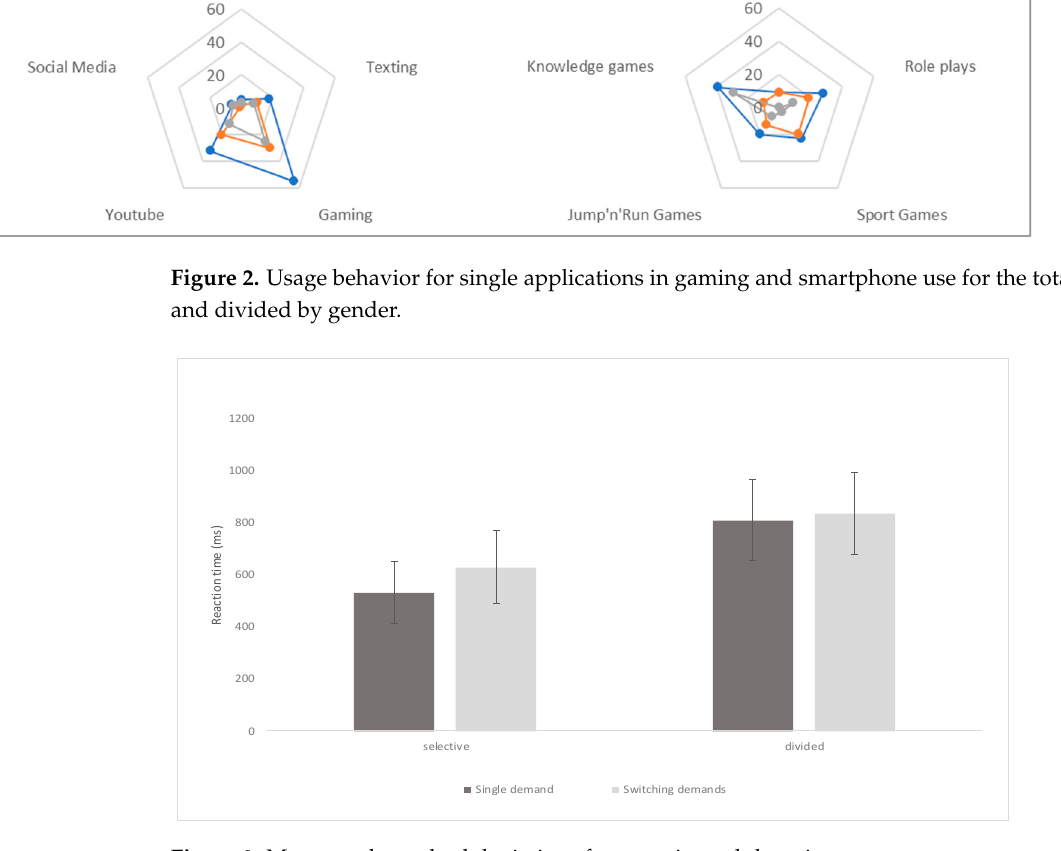
Figure 3. Means and standard deviations for attention subdomains.